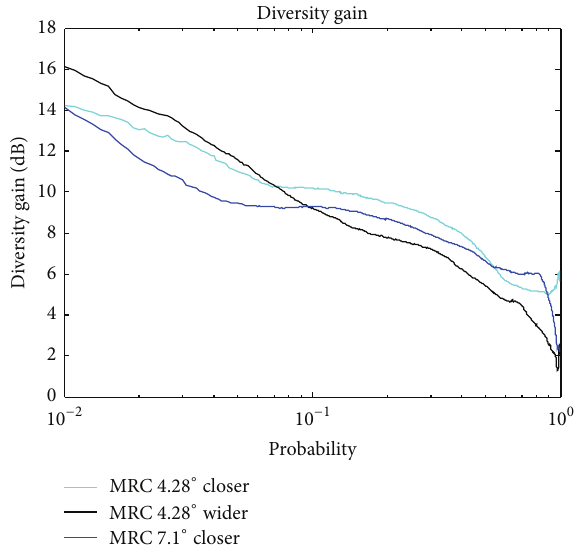
Figure 6: Comparison of diversity gains for two elevation angles in a wooded area.